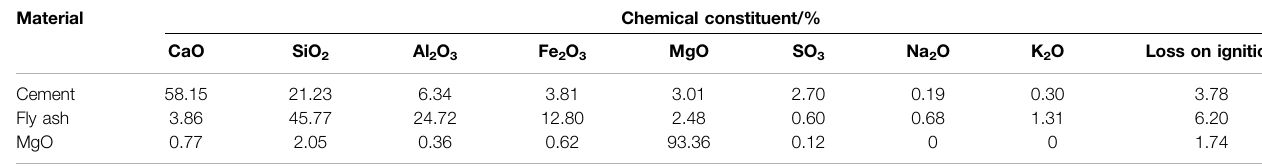
TABLE 1 | Chemical composition of raw materials (mass percent). Material